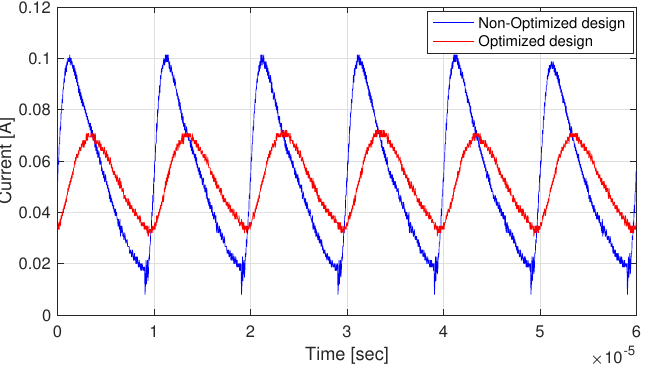
Figure 23. Control signals in the optimized design.